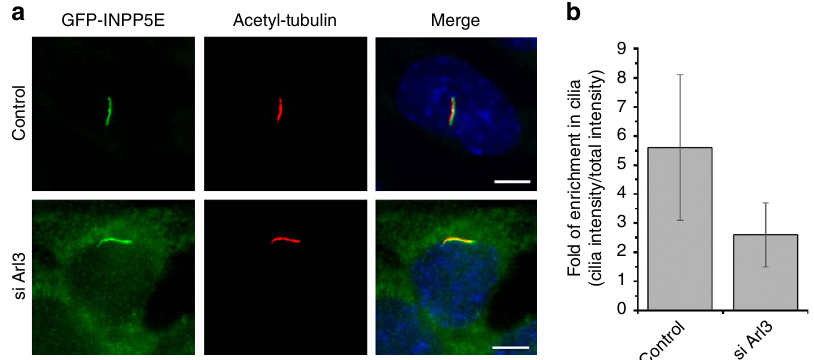
Figure 6 | INPP5E ciliary enrichment is dependent on Arl3. ( a ) Localization of INPP5E (green) in IMCD3 cells which were stably transfected with the LAP-tagged protein followed by the transfection with either negative control siRNA or siRNA directed against Arl3 . White bar indicates 5 m m. ( b ) Bar chart showing ratio of GFP intensity in cilia to the total GFP intensity, indicating the enrichment of GFP-tagged protein in cilia. Data have been collected for 90 cells which were treated with control siRNA and for 82 cells which were treated with siRNA against Arl3 and analysis was performed using CellProfiler. Error bars indicate s.d., n Z 82 ( P o 0.05; Student’s t